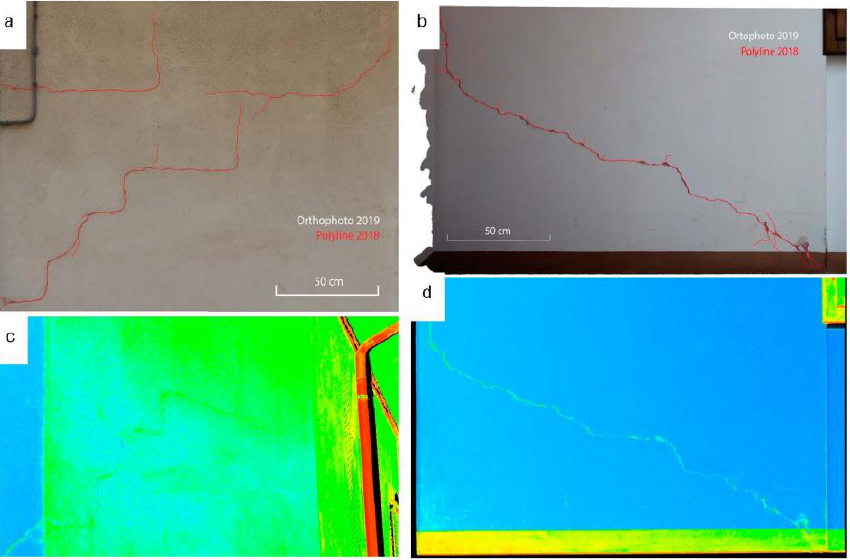
Figure 12. Orthophotos showing the wall of the building in Cappellazzi ( a ) and the portico of Rovegliana Church ( b ) in 2019, with superimposed the traces (red polylines) of the cracks detected in 2018. ( c , d ) are the point clouds derived by TLS for the building and the portico, respectively.